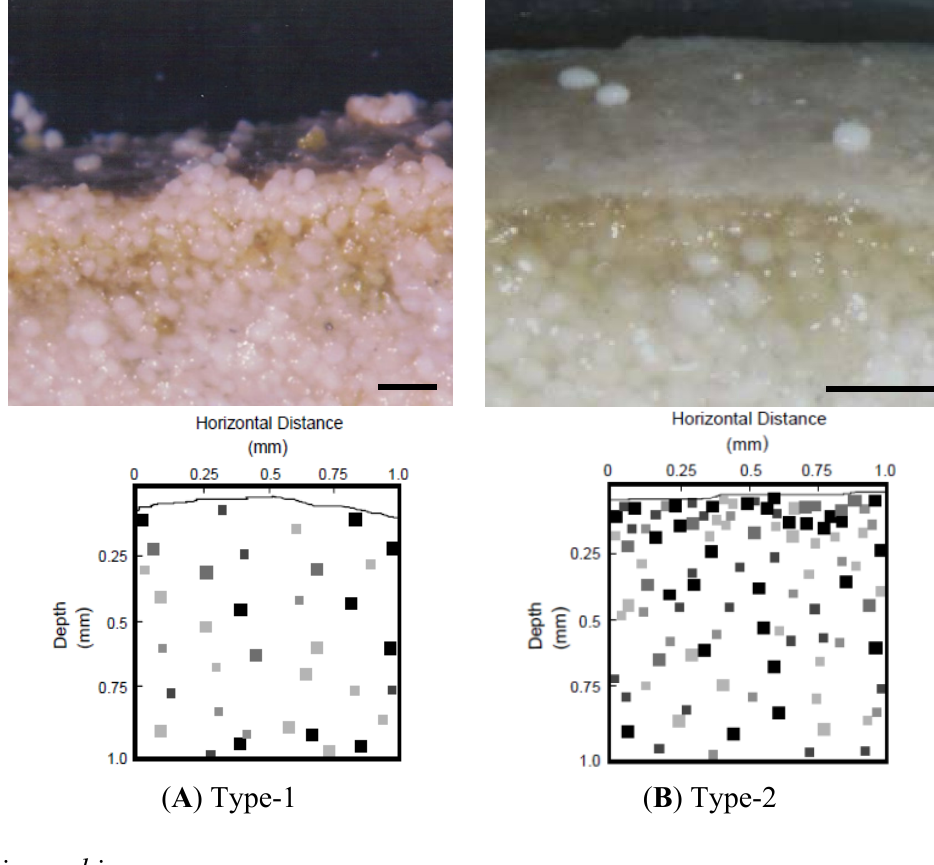
Figure 1. Light micrographs of cross-sections showing surfaces of Type-1 and Type-2 stromatolite mats. Light micrographs of a Type-1 mat ( A ) show an irregular “sticky” EPS-laden surface that accretes ooid grains, while the Type-2 mat ( B ) is characterized by a “non-sticky, white precipitate” crust on the surface. Three ooids have been artificially placed on the Type-2 surface crust to further illustrate the precipitate. Scale bars = 500 µm. Lower panels show 2D images 1 × 1 mm in size of the surface of both mats (light grey line indicates the mat surface). Images were generated from 35 SO 42 − silver (Ag) foil experiments. Mat cross-sections were incubated on silver foil impregnated with the sulfate radioisotope. SRM reduce the 35 SO 42 − to 35 S 2 − , which precipitates as Ag 35 S is was visualized with radiography. Black pixels indicated areas of intense sulfate reducing